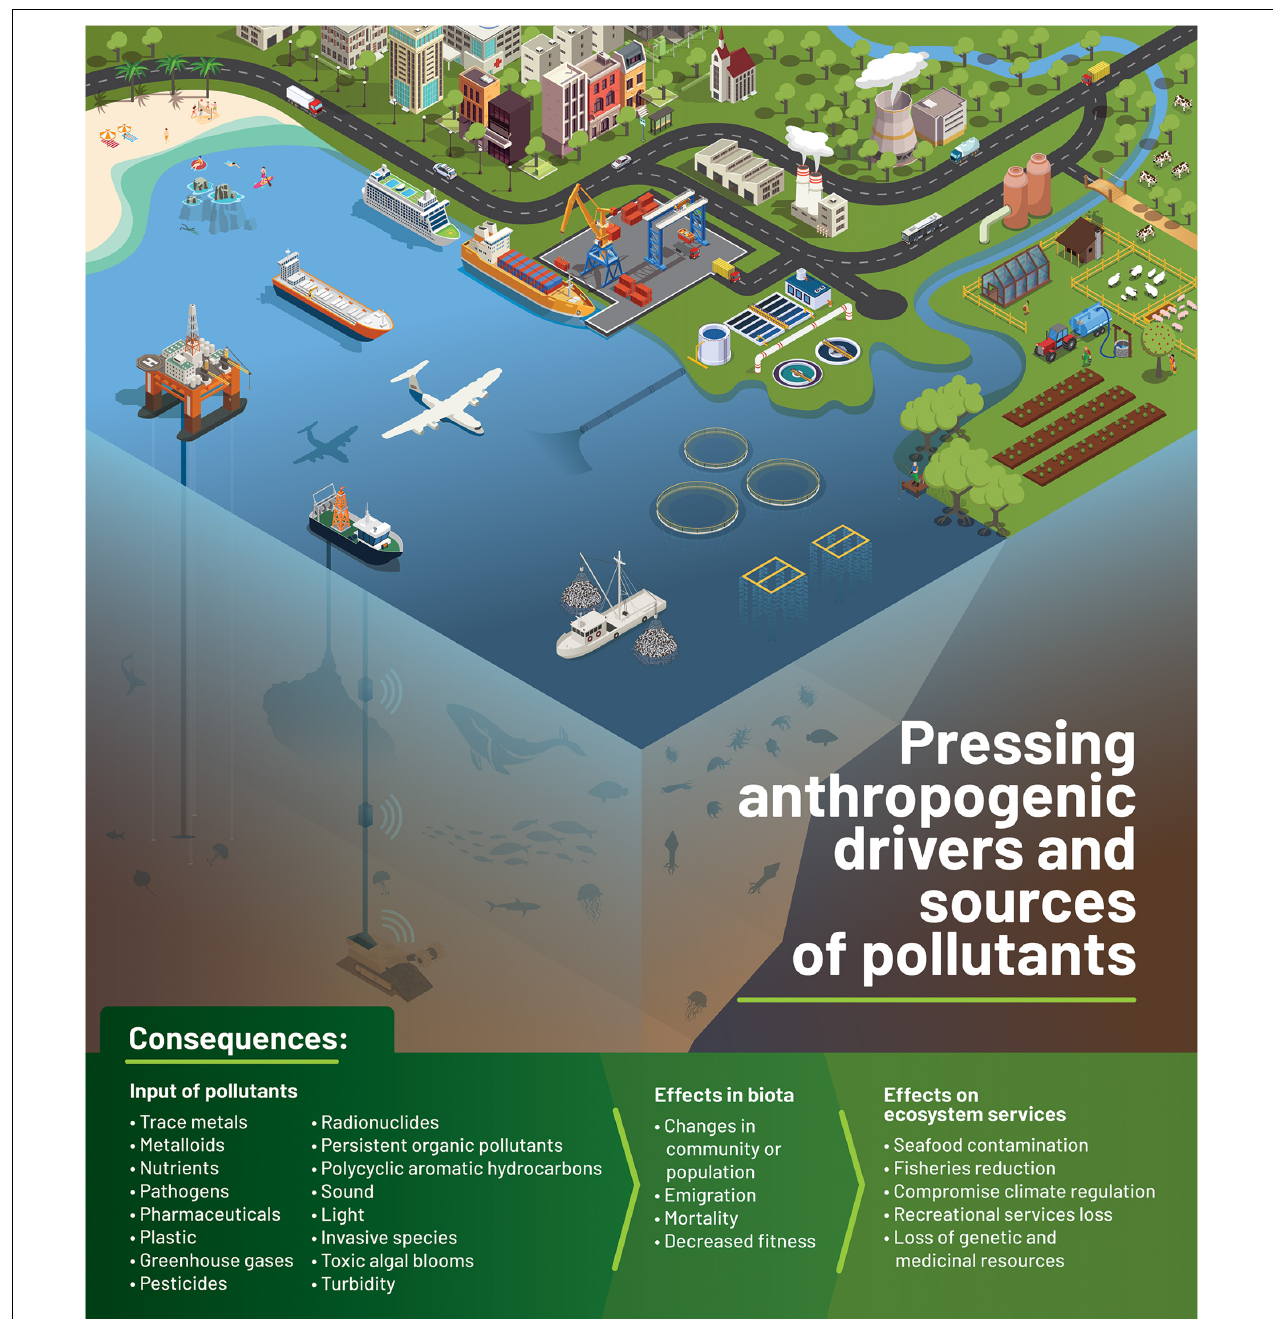
FIGURE 2 | Anthropogenic impact drivers, pollutants and negative impacts on the